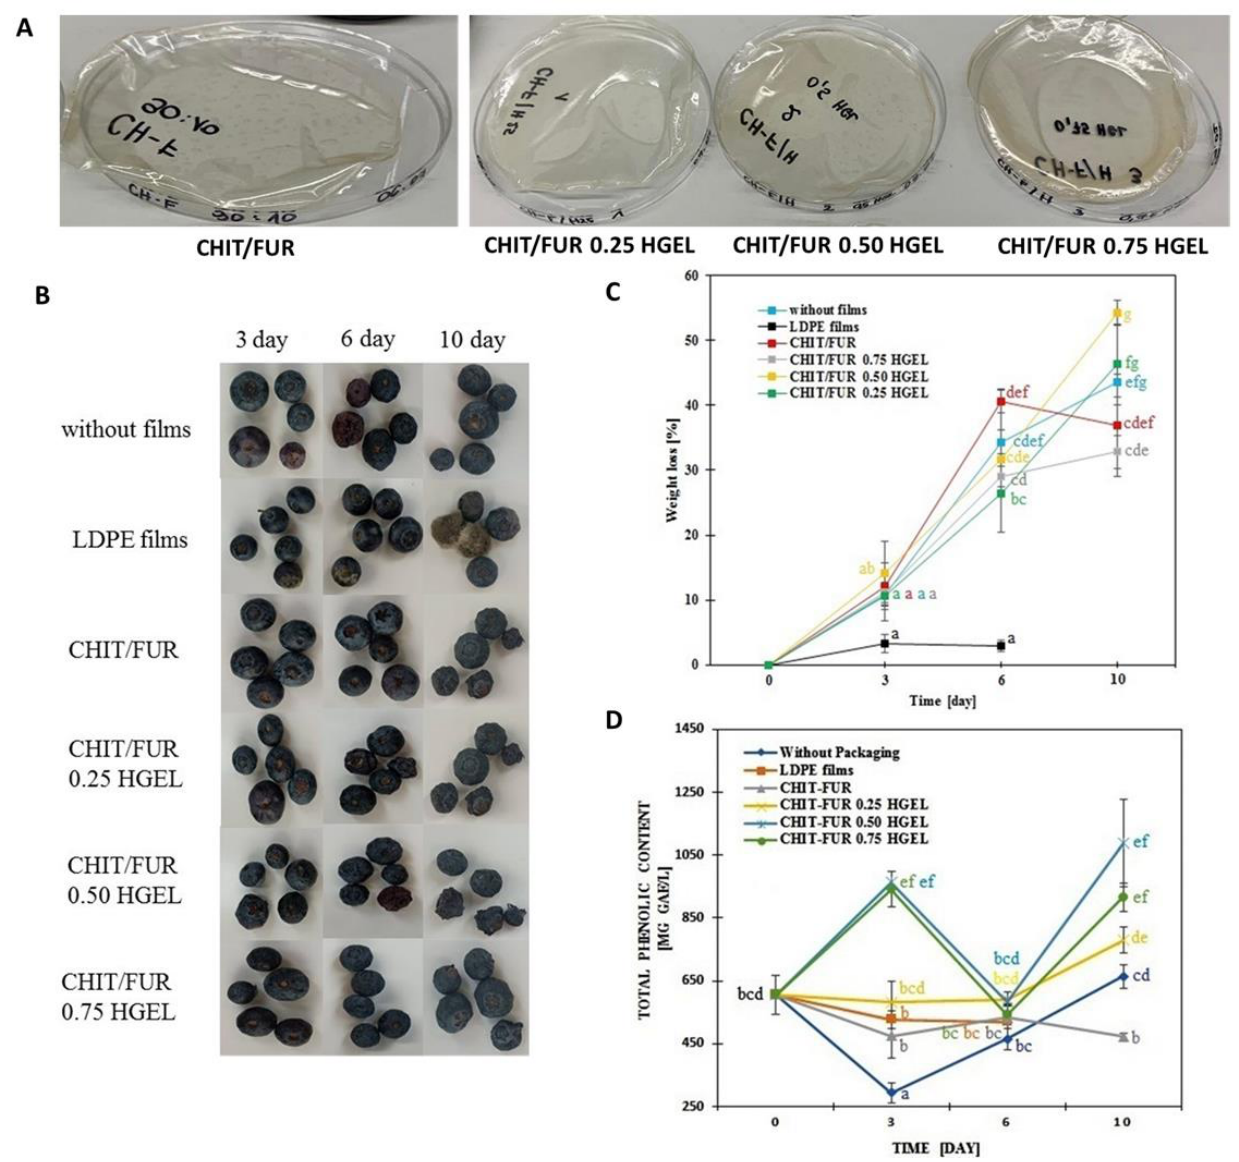
Figure 3. Visual appearance ( A ) of tested films, ( B ) of blueberries after storage, ( C ) weight loss and ( D ) total phenolic content of blueberry storage in different films. The same superscript letters in point demonstrate lack of significant difference between values ( p ˂ 0.05).